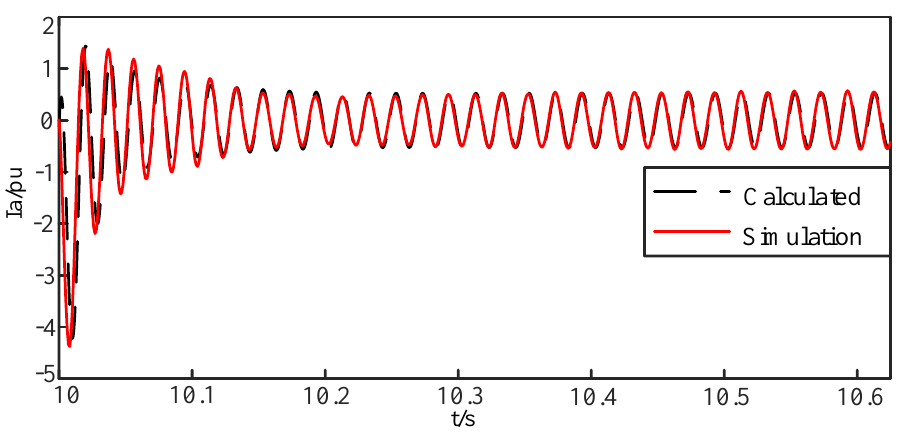
Figure 2. Transient current characteristics of DFIG (Phase A).